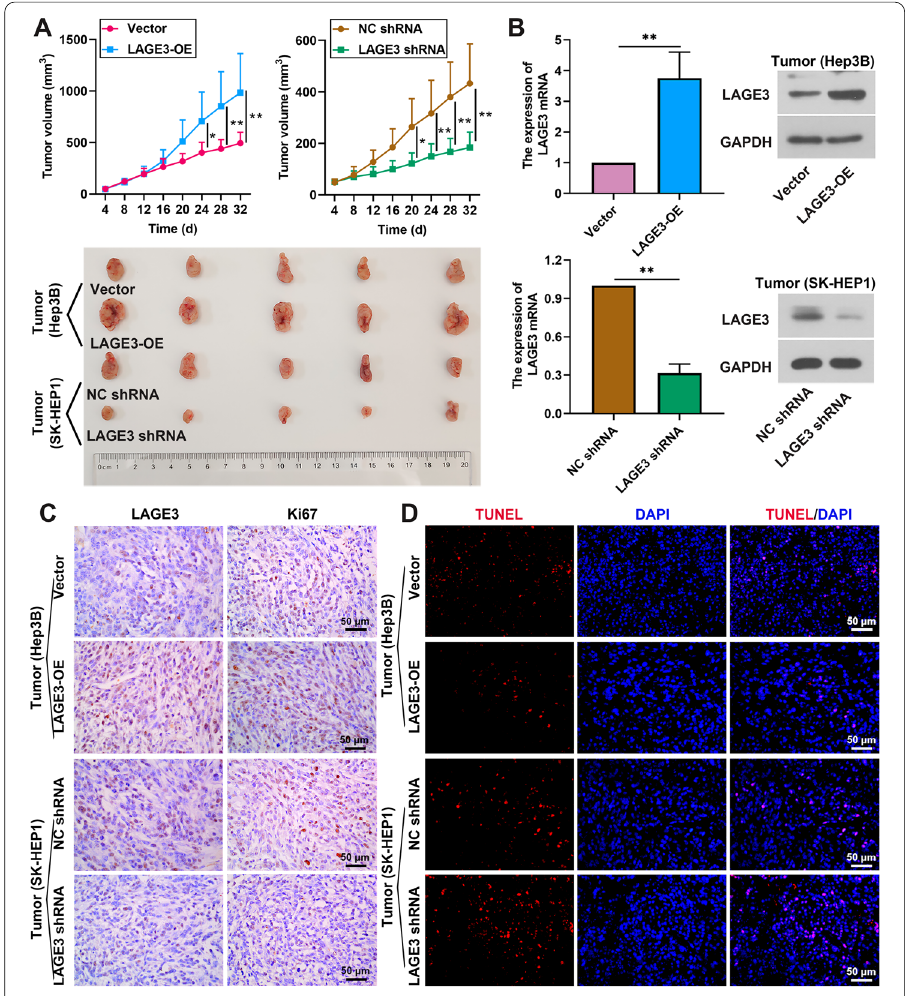
TUNEL staining of late apoptotic cells. Data are shown as mean